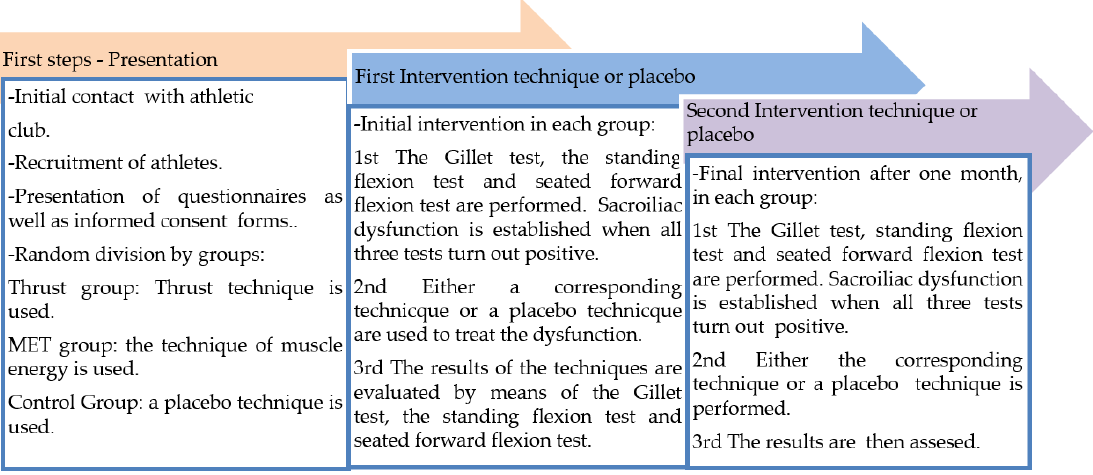
Figure 1. Chronological line of intervention.